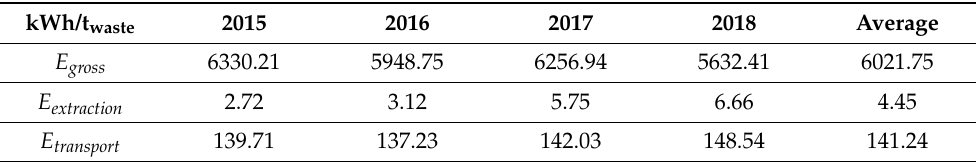
Table 10. Consumed energy in the case of incineration (kWh/t waste ).